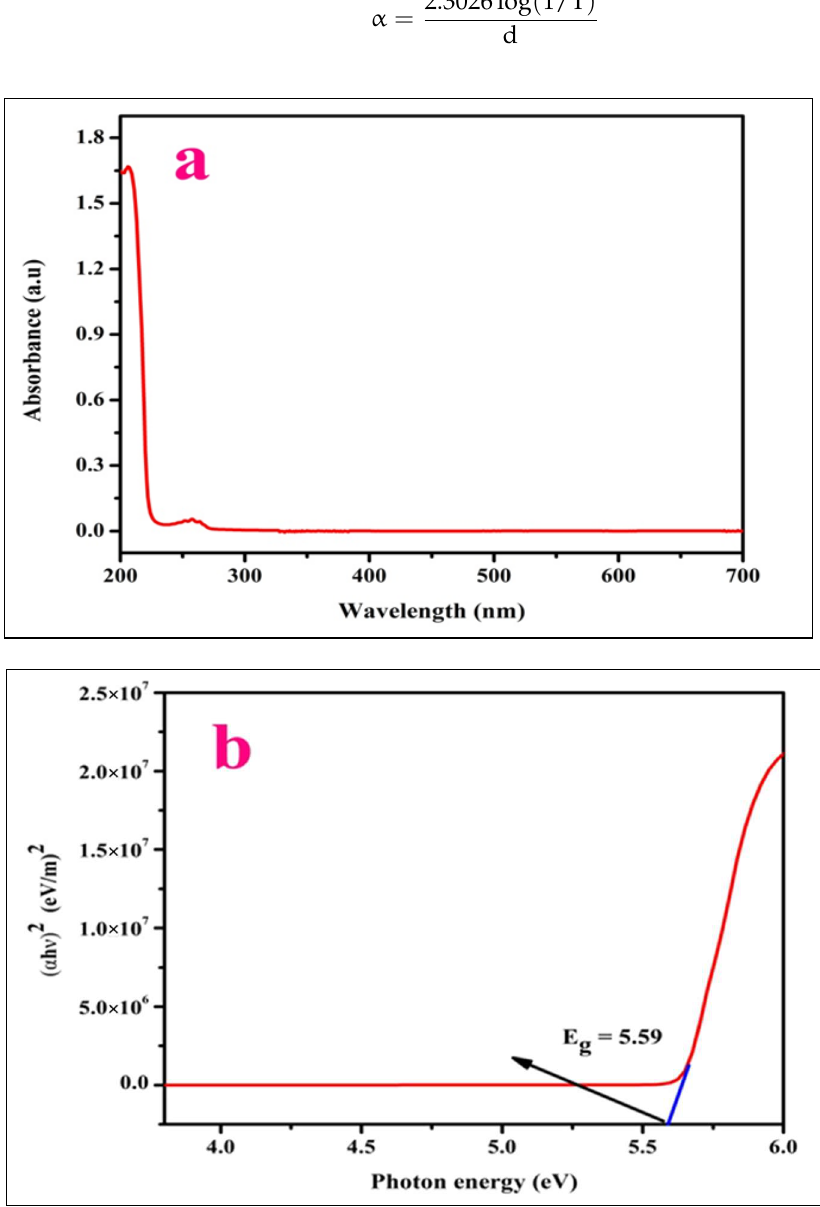
Figure 3. ( a ) Profile of optical spectrum and ( b ) Tauc’s graph of